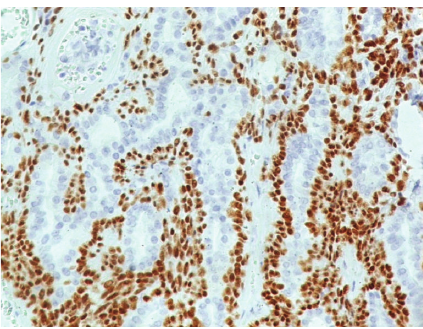
Figure 5: Immunostain for p63 protein ( × 100): nuclear positivity is seen in basal